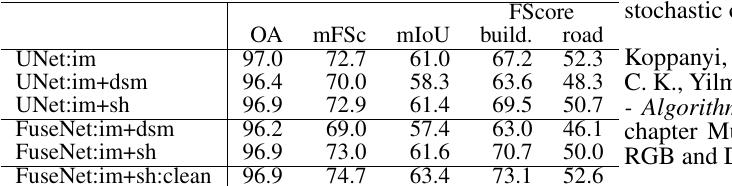
Table 3. Quality metrics (in %) obtained for 1981